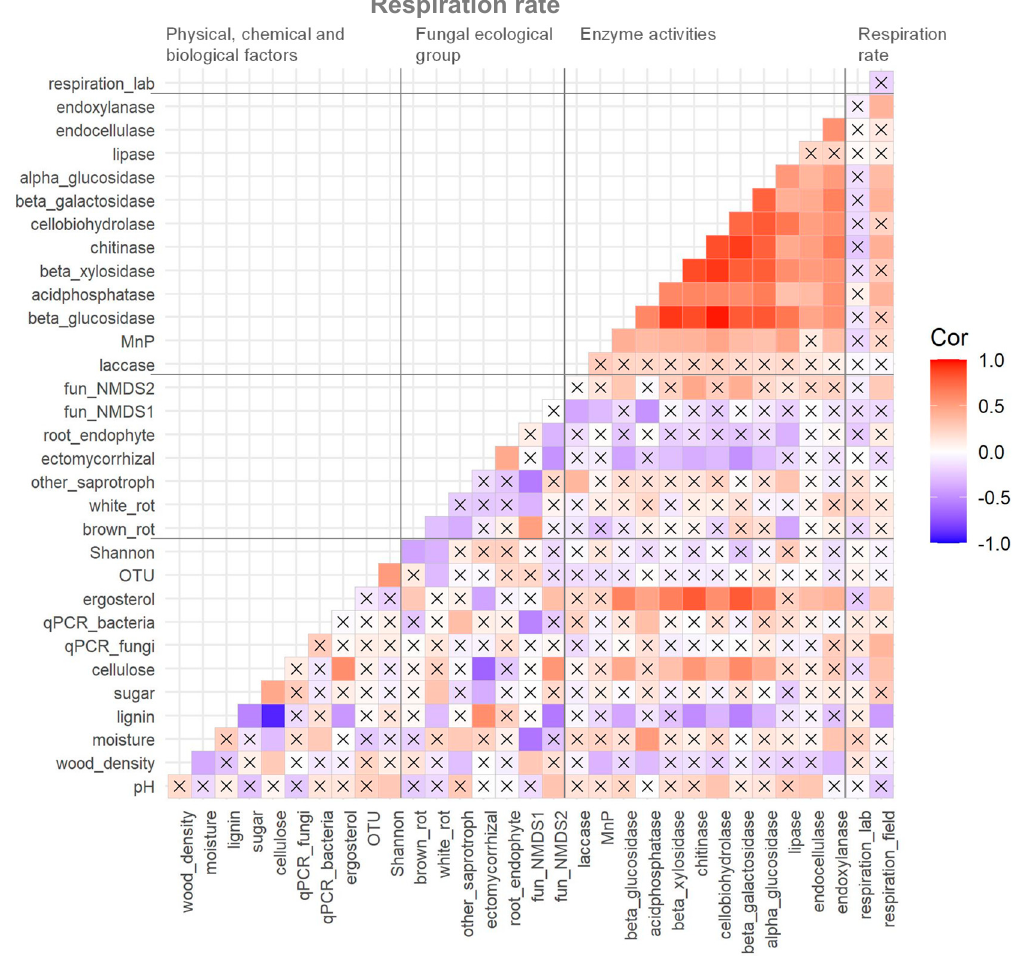
Figure 4. Correlation matrix of measured variables of physico–chemical and biological factors, relative abundance of fungal ecological groups, enzyme activities, and respiration rate of dead wood in the Zofin Forest. The cross marks indicate the absence of significant correlation ( p < 0.05). The factors selected for the final GLM were lignin content ( p < 0.01) and acid phos- phatase activity ( p < 0.01), and the model explained 31% of the variation in respiration rate in situ. Acid phosphatase and lignin content were significantly positively and negatively correlated, respectively, to the respiration rate (Figure 4).